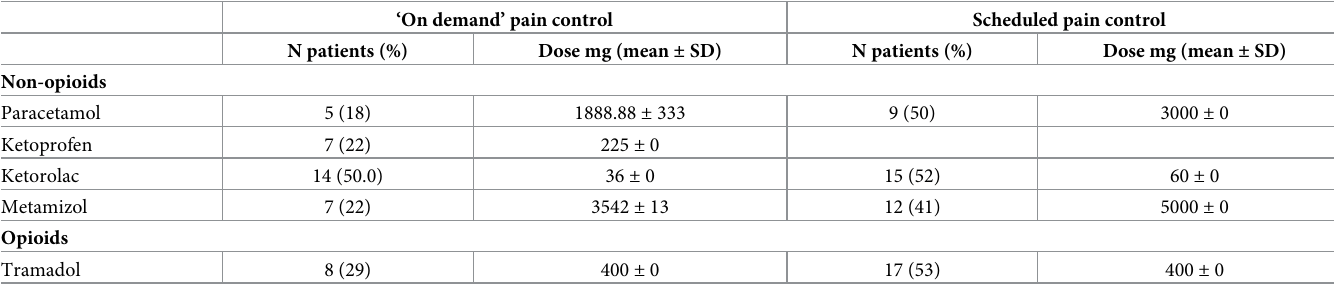
Table 2. Anagesics administered on the first day after surgery in the two